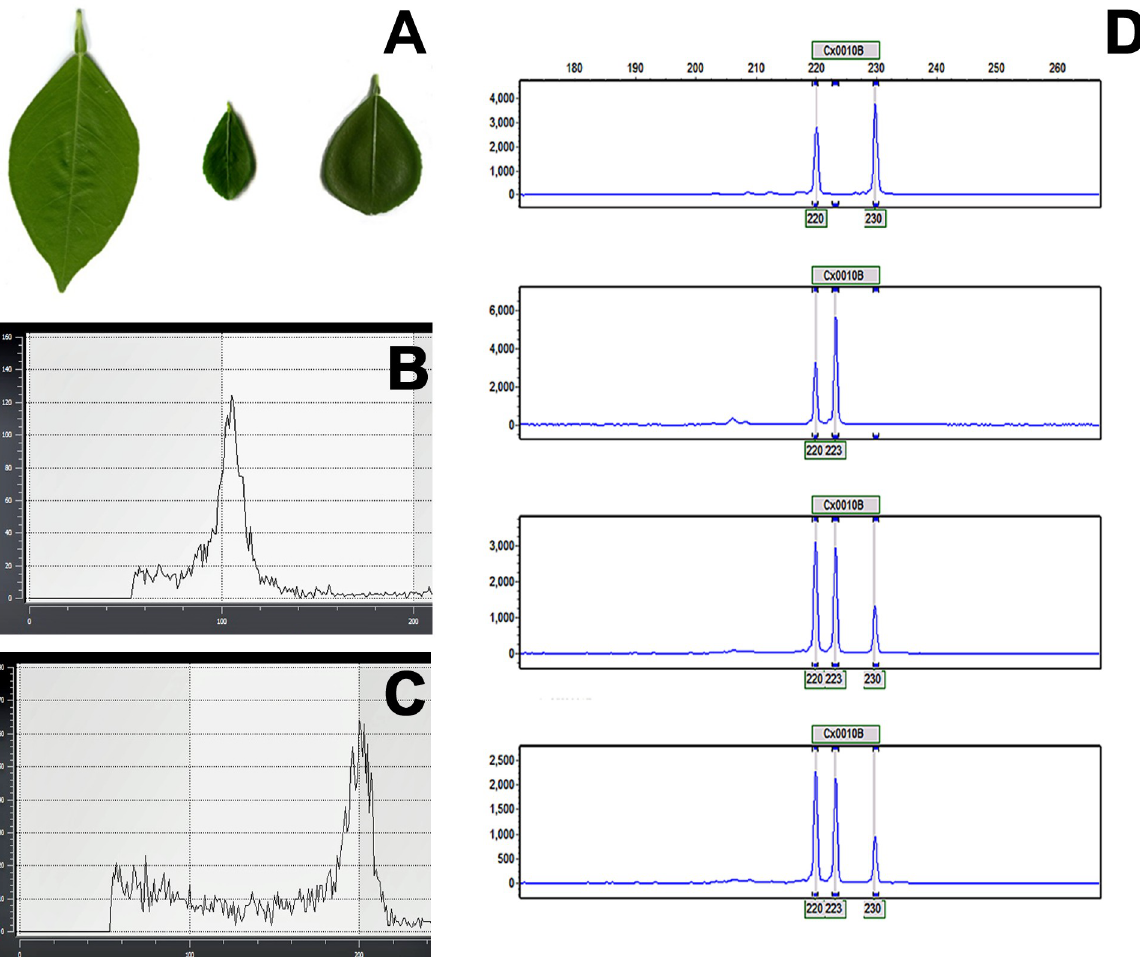
Fig 1. Characterization of somatic fusions. A) Morphological changes in leaves of the diploid parents (left, OLL8; middle; FL) and an OLL8+FL allotetraploid (right). B) and C) Ploidy analysis using flow cytometry. Diploid (B) and tetraploid (C) peaks derived from control and OLL8 + finger lime somatic fusion lines. D) A chromatogram of EST-SSR marker CX0010 labeled with 6-FAM generated from ABI trace files by GeneMarker 1 software (SoftGenetics). Top panel; OLL8 sweet orange (2X), Middle panel; finger lime (2X) Third and fourth panel; two independent OLL8 + FL (4X) lines.